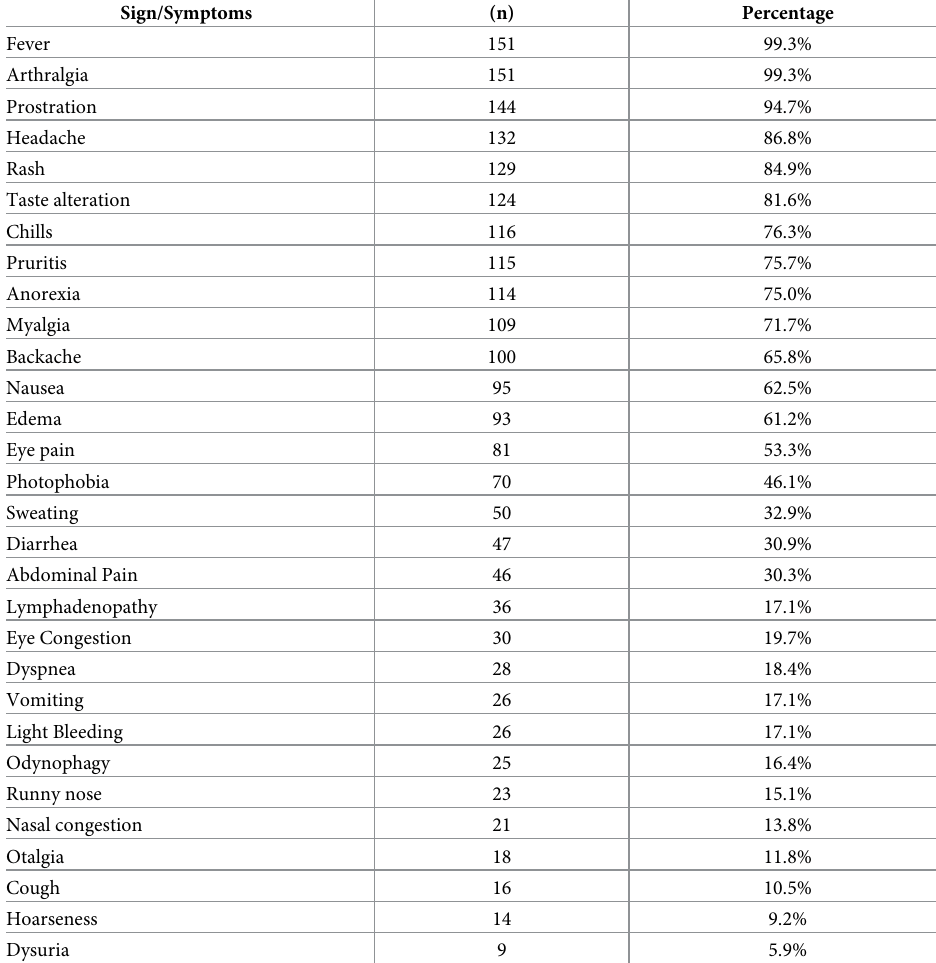
Table 2. Signs or Symptoms at Acute Phase of the Disease (1–14 days).